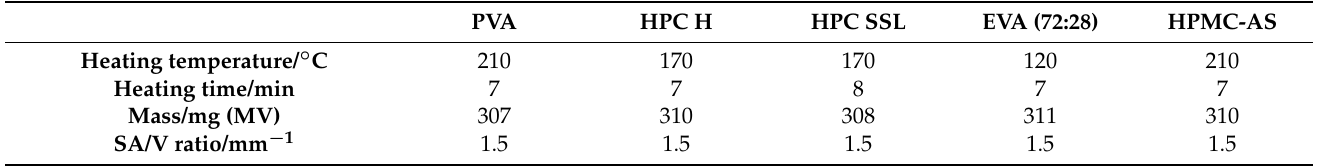
Table 3. VCM-Process settings for different